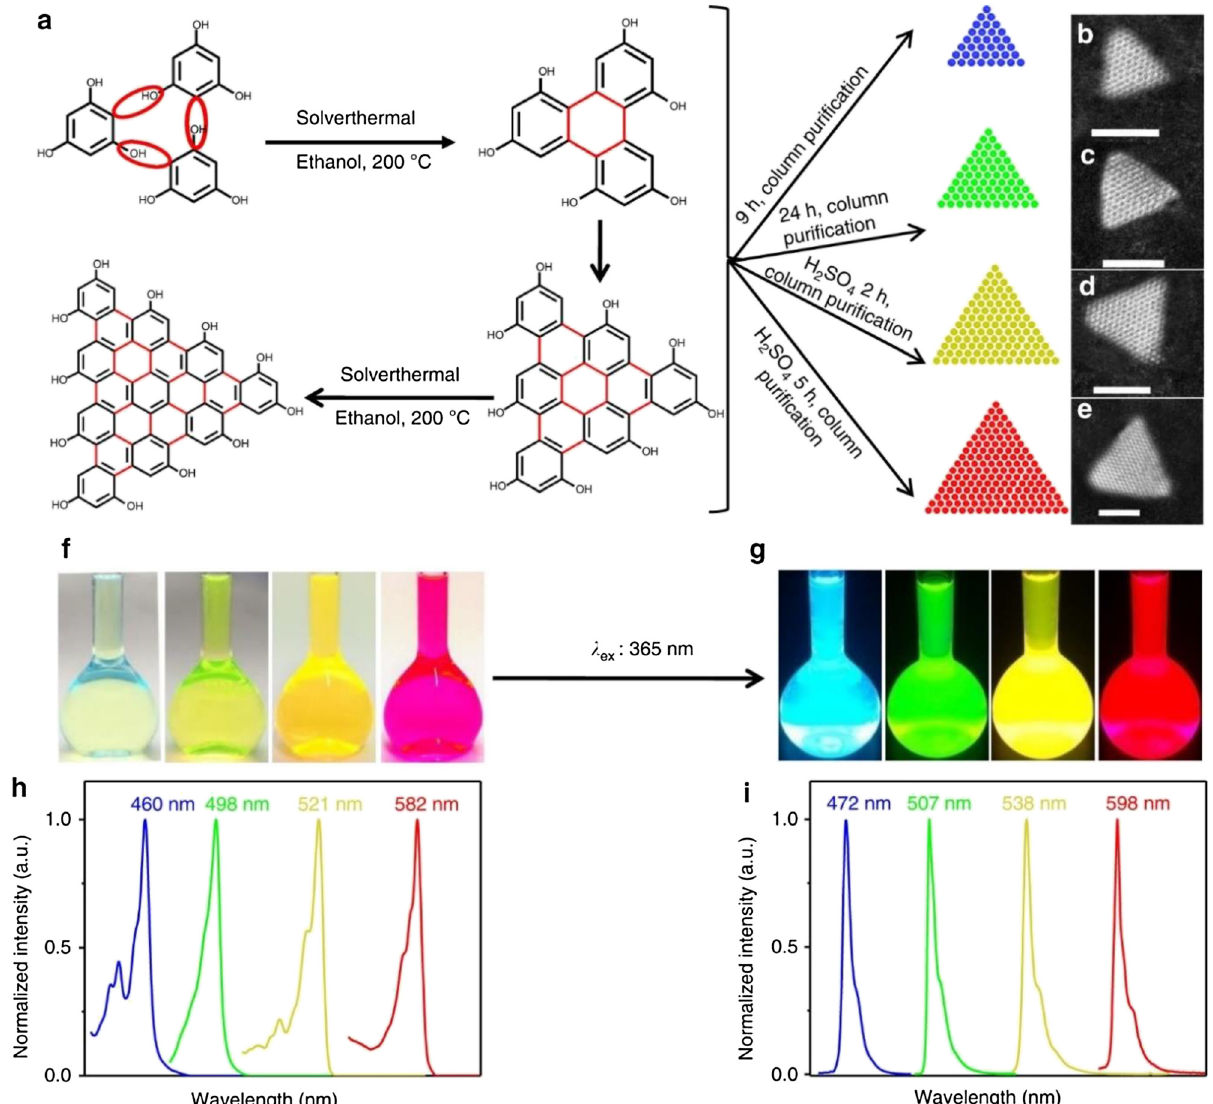
Figure 15: Design and synthesis of narrow bandwidth emission triangular CQDs. ( a ) Synthesis route of the NBE-T-CQDs by solvothermal treatment of PG triangulogen. The typical aberration-corrected HAADF-STEM images of ( b )B-,( c )G-,( d )Y-,and( e )R-NBE-T-CQDs,respectively.Scalebar,2nm.PhotographsoftheNBE-T-CQDsethanolsolutionunder( f )daylightand ( g ) fl uorescence images under UV light (excited at 365 nm). The normalized ( h ) UV – vis absorption and ( i ) PL spectra of B-, G-, Y-, and R-NBE- T-CQDs, respectively